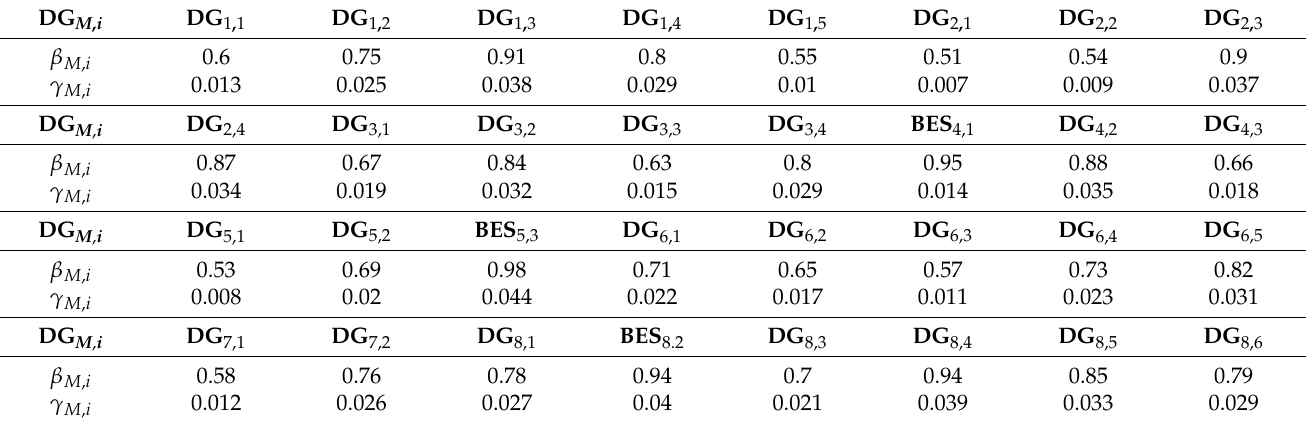
Table 3. The 41-node power system’s DGs Generation Costs.